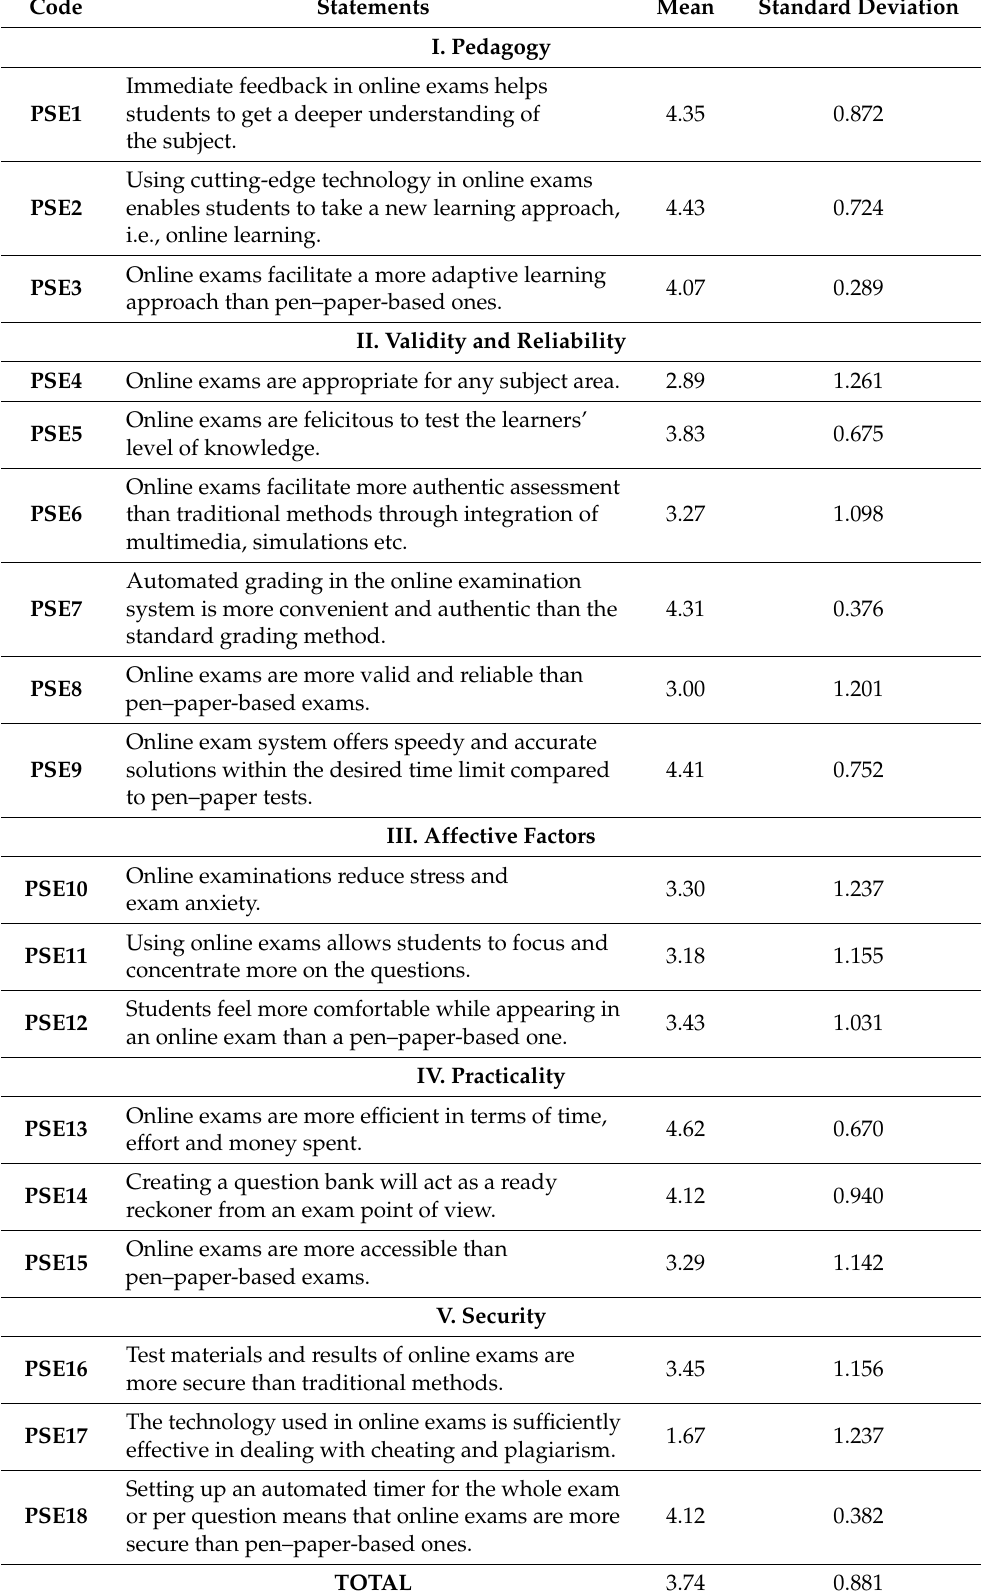
Table 6. Perception of Students towards Online